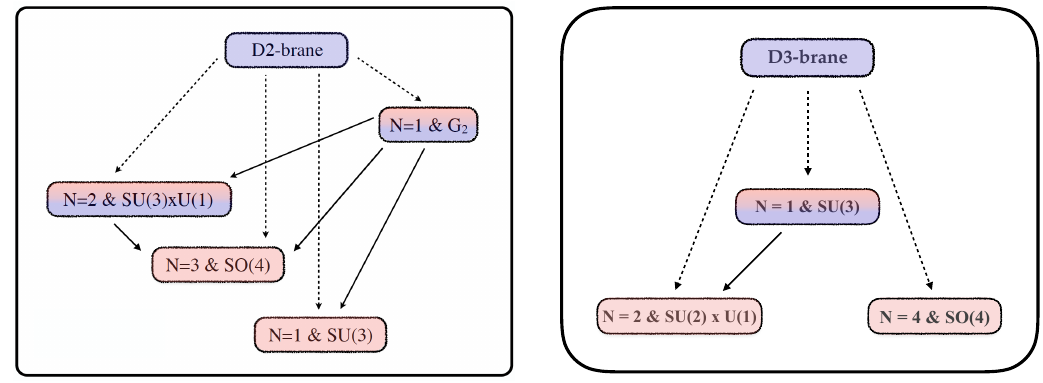
Figure 1 . Left: network of domain-walls connecting the D2-brane behaviour (SYM 3 -CS) and the known supersymmetric AdS solutions (CFT ’s) of the ISO(7) maximal supergravity. Right: 4 3 network of domain-walls connecting the D3-brane behaviour (anisotropic SYM ) and the known 4 supersymmetric AdS solutions (J-fold CFT ’s) of the dyonically-gauged [ SO (1 , 1) × SO (6) ] n R 12 4 3 maximal supergravity. In both diagrams, domain-walls connecting AdS solutions are denoted by 4 solid